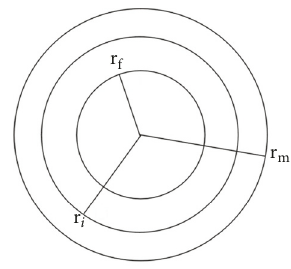
Figure 1: Coaxial three-phase cylinder unit